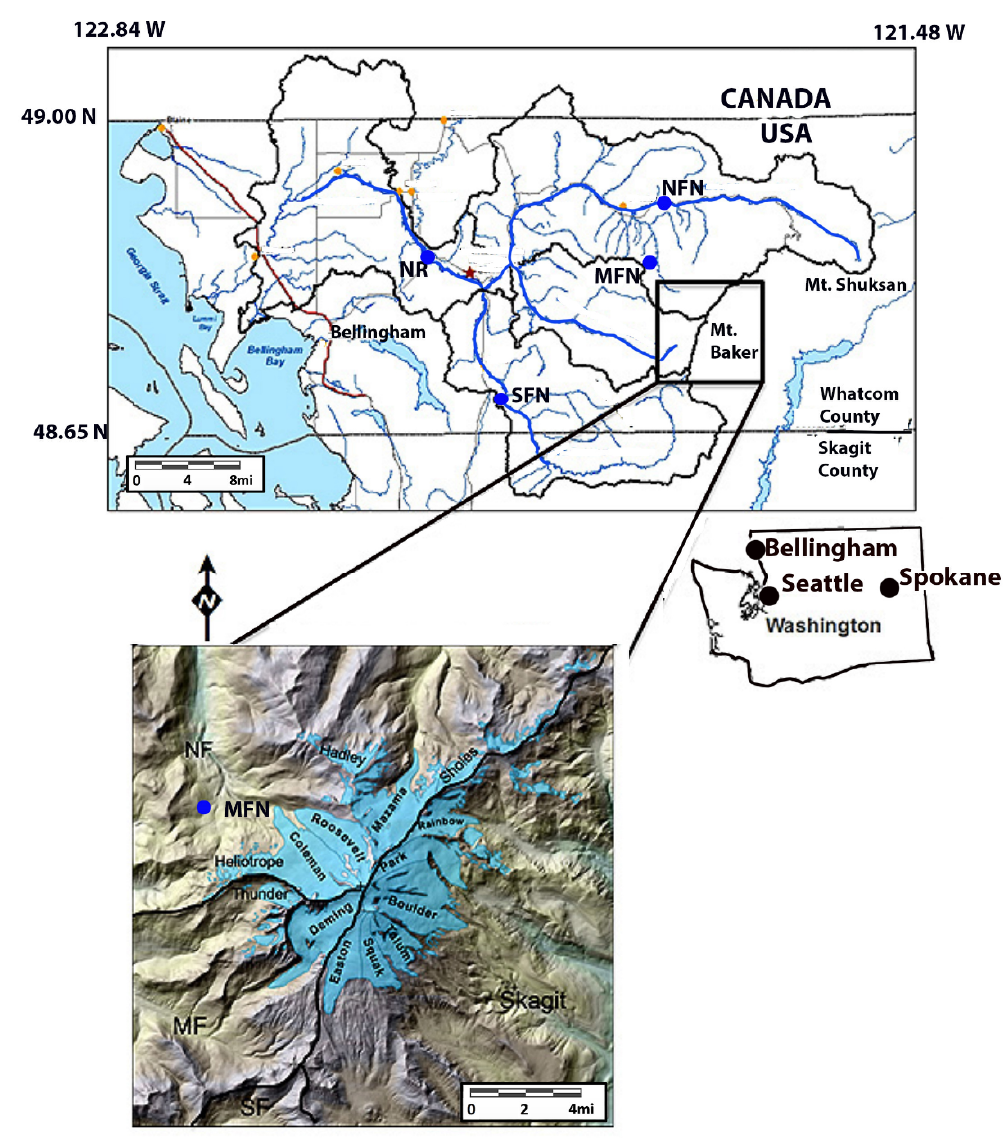
Figure 1. Map of Mount Baker glaciers and the Nooksack River Watershed. USGS gage locations for the Nooksack River (NR), North Fork Nooksack River (NFN), and South Fork Nooksack River (SFN) are indicated with blue dot. The Middle Fork Nooksack SNOTEL station (MFN) also indicated with blue dot, on inset also. Yellow dots mark cities, Red line is the I−5 highway and the red star is the Nooksack Indian Tribal Center.